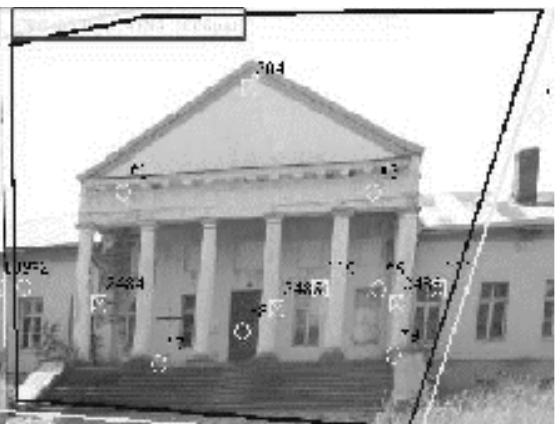
Fig. 4. Geometric model of central side of Arnionys facade Table 3. Precision rate of model